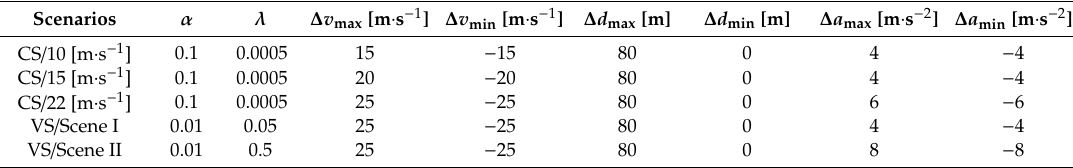
Table 1. Parameters for PBLS.